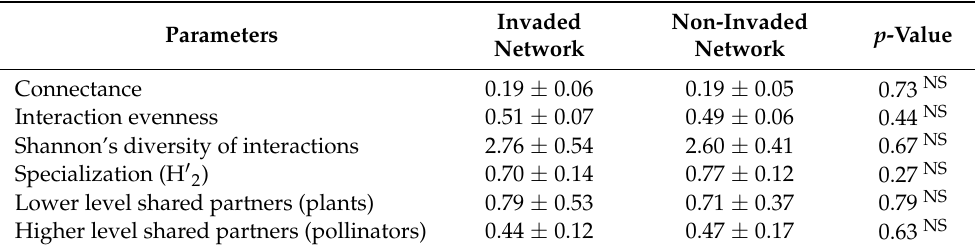
Figure 3. Pollination network showing the interactions between pollinators (top blue bars) and plants (bottom green bars), (the networks were combined for all sites and morphospecies for illustrative purposes); ( a ) network of all study sites ( n = 18), ( b ) non-invaded network ( n = 9), and ( c ) invaded network ( n = 9). The width of the links is proportional to the number of interactions observed (the list of plants and pollinators species in these networks is found in Supplementary Material, Table S1). Size and complexity should be examined rather than species names (other than Praxelis-which is shown in red). Table 2. Mean ± SD value of the network structure parameters. Connectivity, interaction evenness, Shannon’s diversity of interactions, specialization (H (cid:48) 2 ), and mean number of shared partners for the lower level (plants) were analyzed using Wilcoxon rank sum test. Mean number of shared partners higher level (pollinators) was assessed using a t -test. NS p >